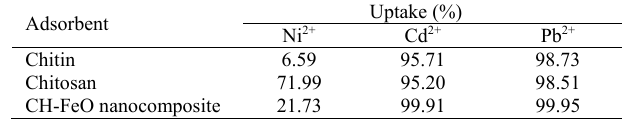
Table 5: Removal of Ni 2+ , Cd 2+ and Pb 2+ from real sample with studied adsorbents